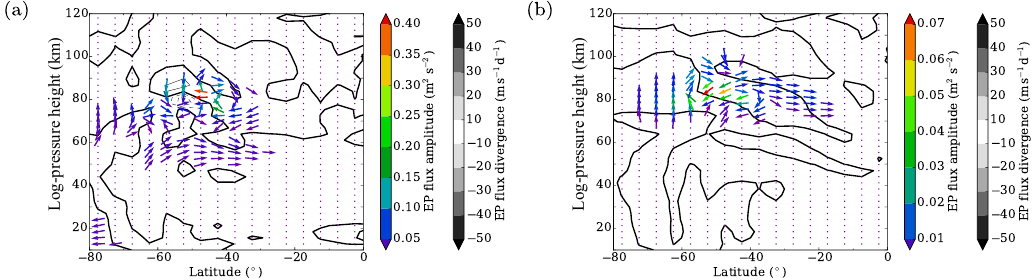
Figure 8. Run3 EP flux vectors for SPW1 (a) and SPW2 (b) . Normalized arrows represent the direction of EP flux. EP flux components are scaled by ρ 0 a cos φ , and their amplitude (in m 2 s − 2 ) is given by color coding. Only points where the amplitude is less than 1% of the maxi- mum amplitude in the field are shown. EP flux divergence, also scaled by ρ 0 a cos φ , is added as solid (dashed) isolines for positive (negative) values. Contour intervals are 2ms − 1 d − 1 between − 10 and 10ms − 1 d − 1 , and otherwise 10ms − 1 d − 1 starting from ± 10ms − 1 d − 1 (also indicated in